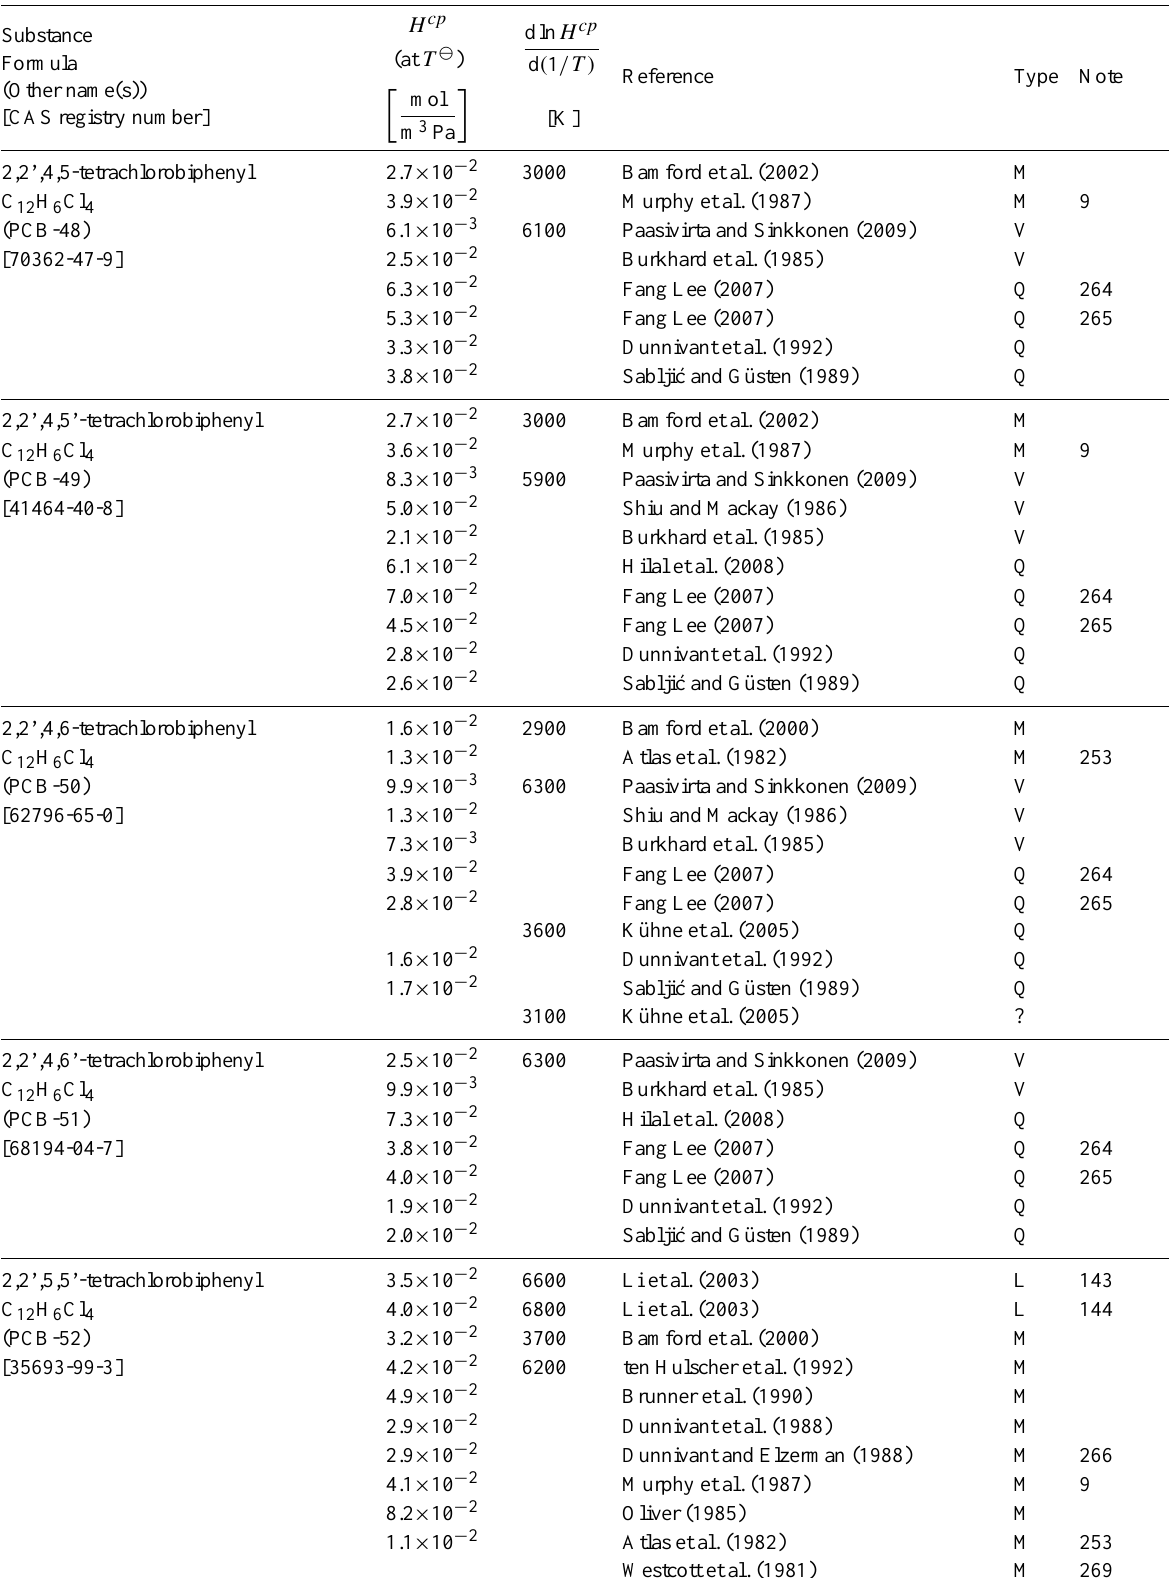
Table 6: Henry’s law constants for water as solvent